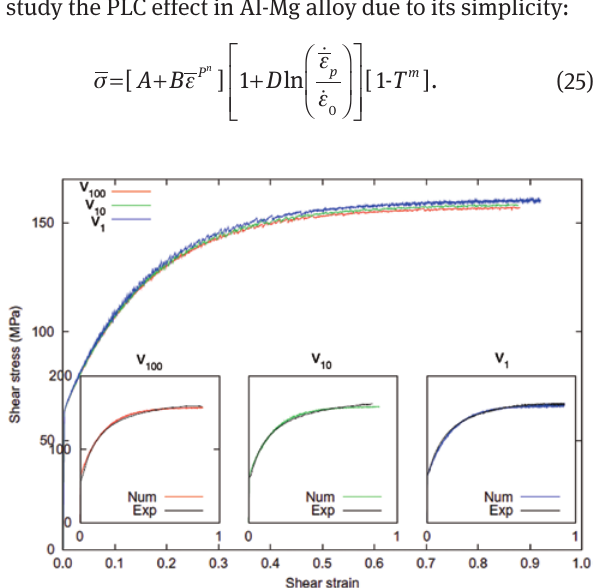
Figure 7: A comparison between the predicted and experimentally measured shear stress-shear strain curves. These values are for an Al alloy using McCormick model for three different strain rates v , v and V representing e-3, γ = (cid:31) 1.2 1 10 100 e-2 γ = (cid:31) 1.2 and e-1 γ = (cid:31) -1 1.25 s , respectively